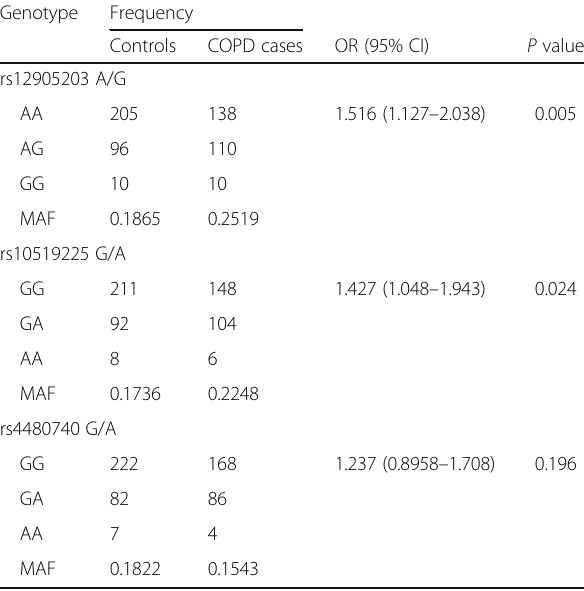
Table 2 Associations of rs10519225 and rs10519255 with